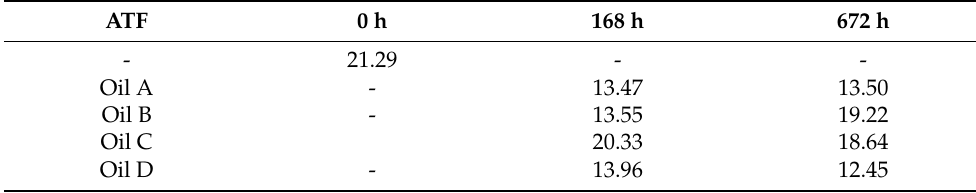
Table 5. Crystallinity percentage of the FKM samples for different aging times.